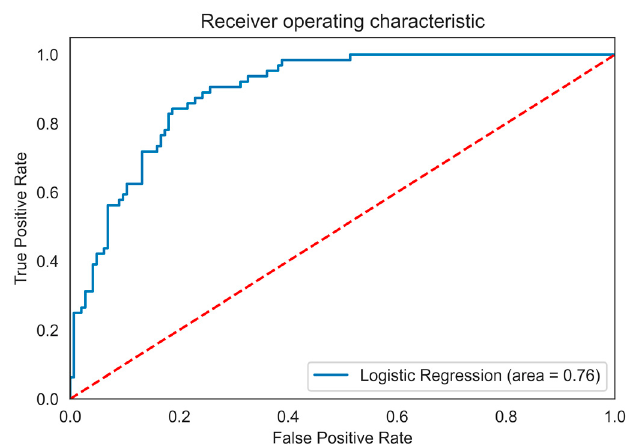
Figure 5. Receiver Operating Characteristic (ROC) curve and Area Under Curve (AUC) score for the estimated model.